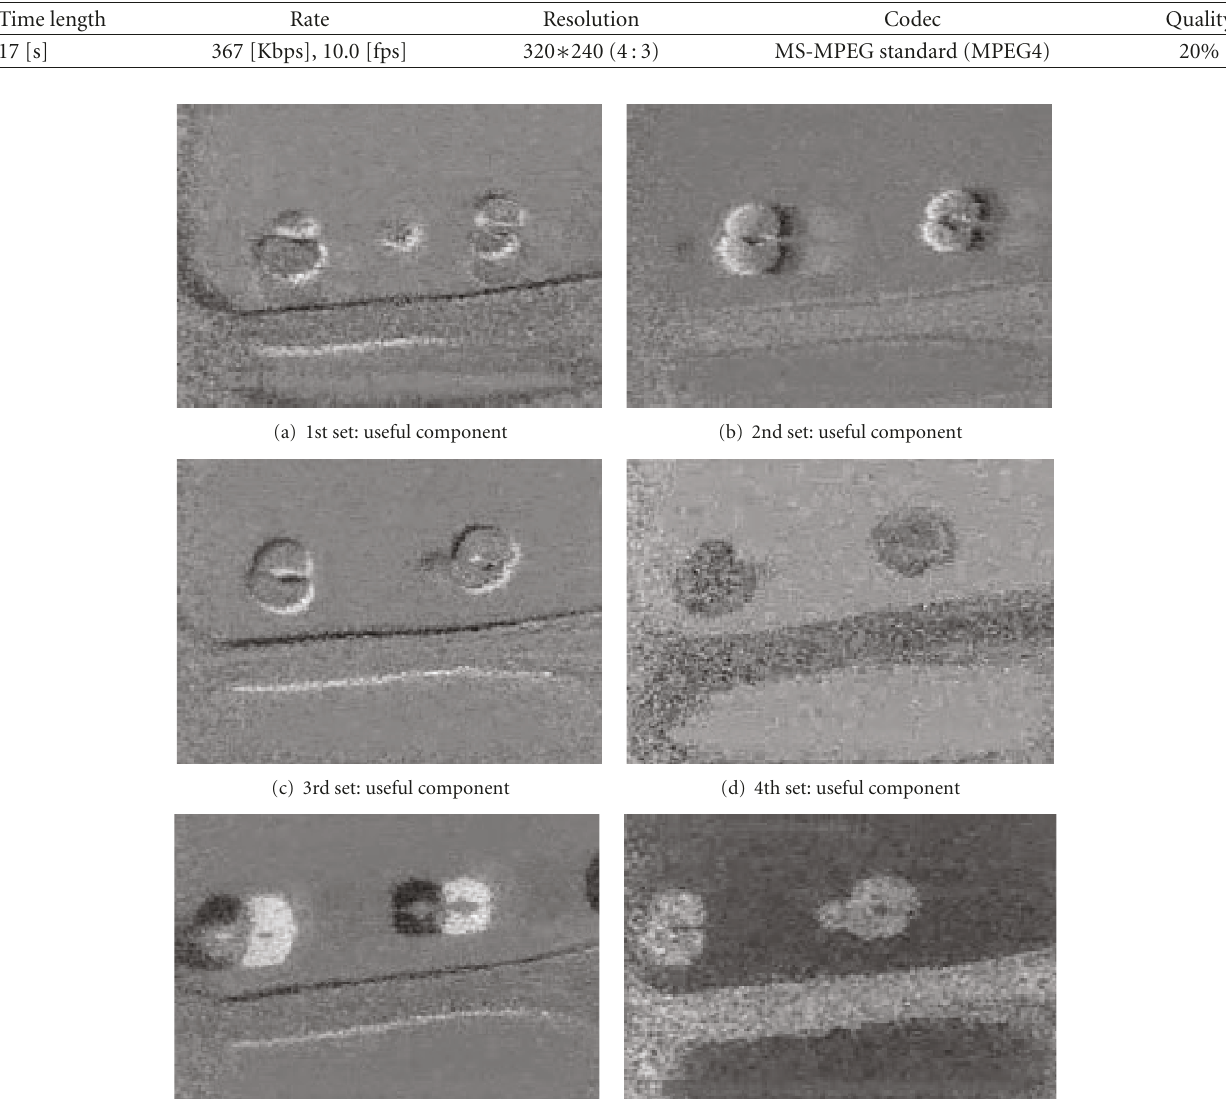
Table 1: Characteristics of the AVI movie file exploited in this experimentation.